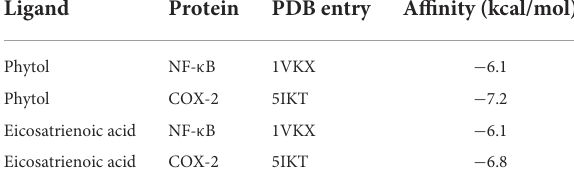
TABLE 1 Molecular docking affinity (kcal/mol) of phytol and eicosatrienoic acid with NF- κ B and COX-2,